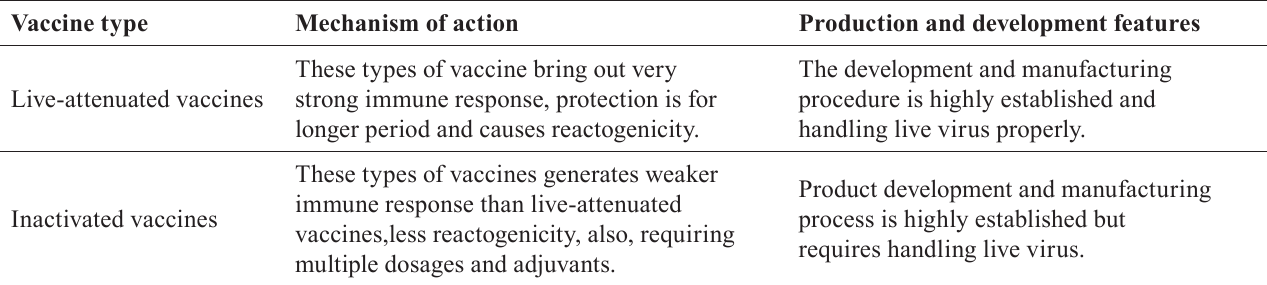
TABLE I - D ifferent types of vaccines, their mechanism of action and development process Vaccine